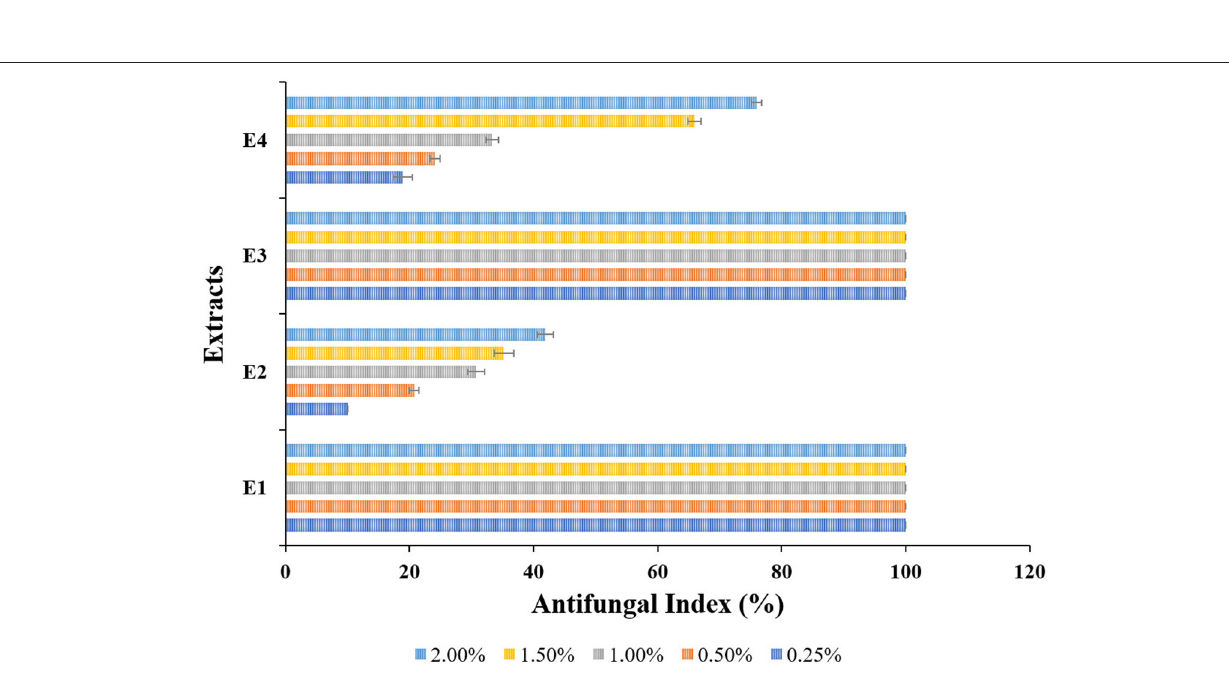
Frontiers in Plant Science |